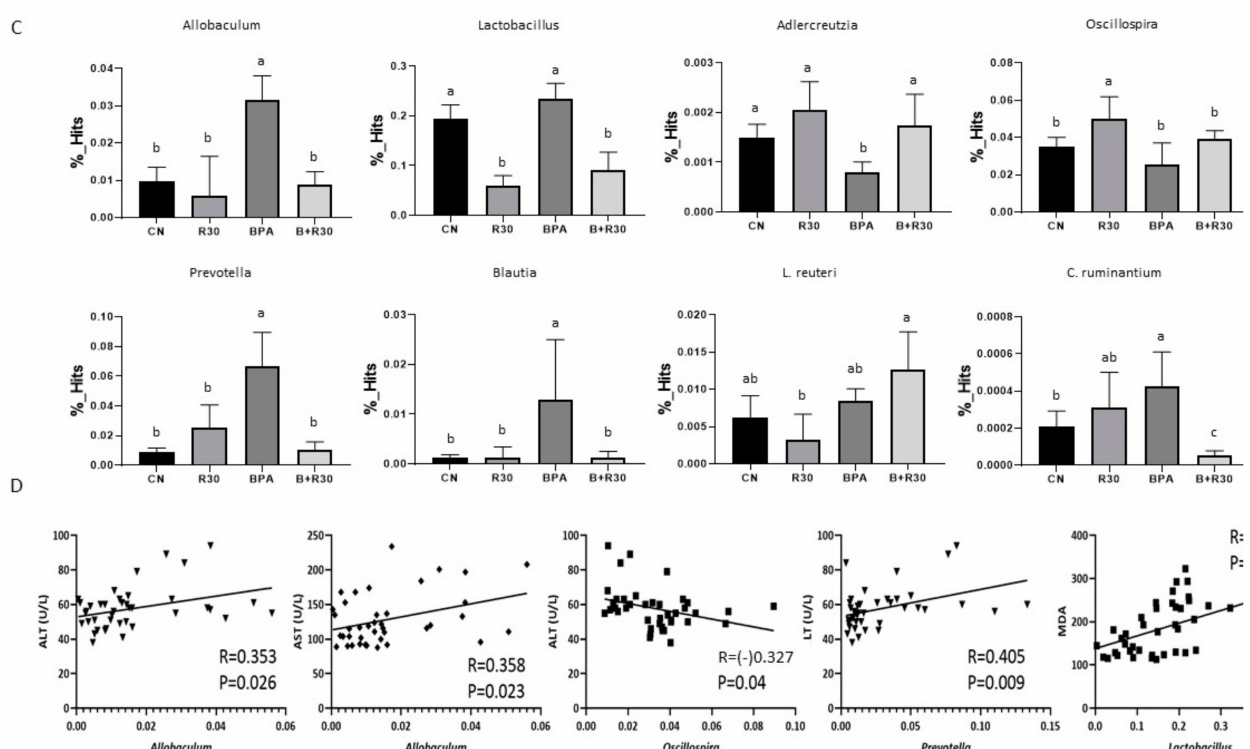
Figure 3. Effect of BPA and RBE on the gut microbiota of male offspring rats. ( A ) The gut bacterial composition at the phylum level. ( B ) Biomarker taxa generated from LEFSe analysis (LDA > 3). ( C ) Comparison of the growth and decline of specific strains. ( D ) The correlation analysis of bacterial species and plasma biochemical indicators. n = 4–8 per group; a–b p < 0.05, significantly different from other groups. CN = control group; R30 = group administered 30 mg/kg/day of RBE; BPA = group administered bisphenol A at 50 µ g/kg/day; BPA + R30 = group administered 30 mg/kg/day of RBE and bisphenol